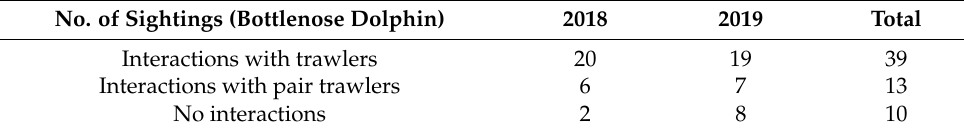
Table 1. Number of sightings of bottlenose dolphins in Agrigento waters between 2018 and 2019. The number of sightings in which dolphins interact with trawlers, interact with pair trawlers, or have no interactions are shown.